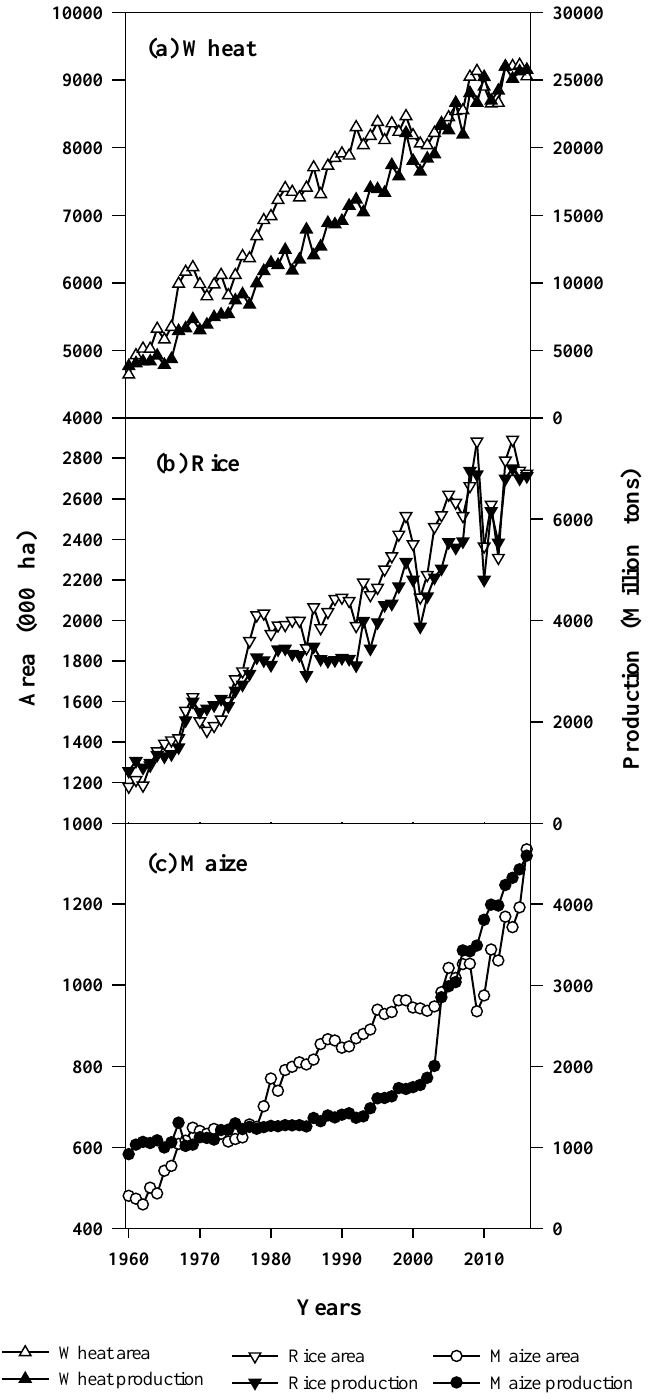
Figure 1. Wheat, rice, and maize area and production in Pakistan from 1960 to 2016. Source: Government of Pakistan [7].